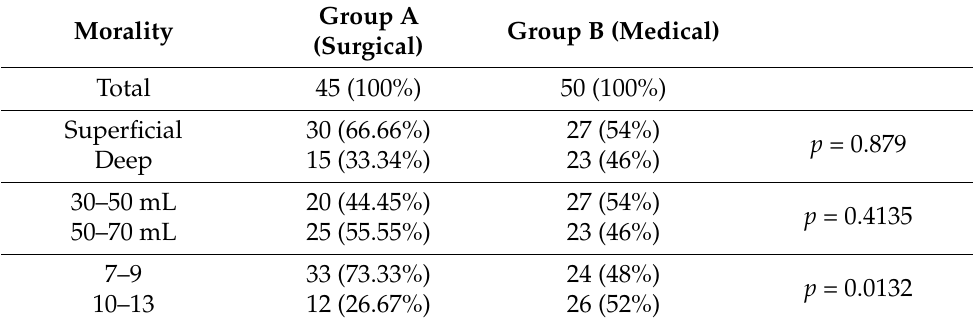
Table 2. Mortality in the groups with surgical indications (Group A and B).